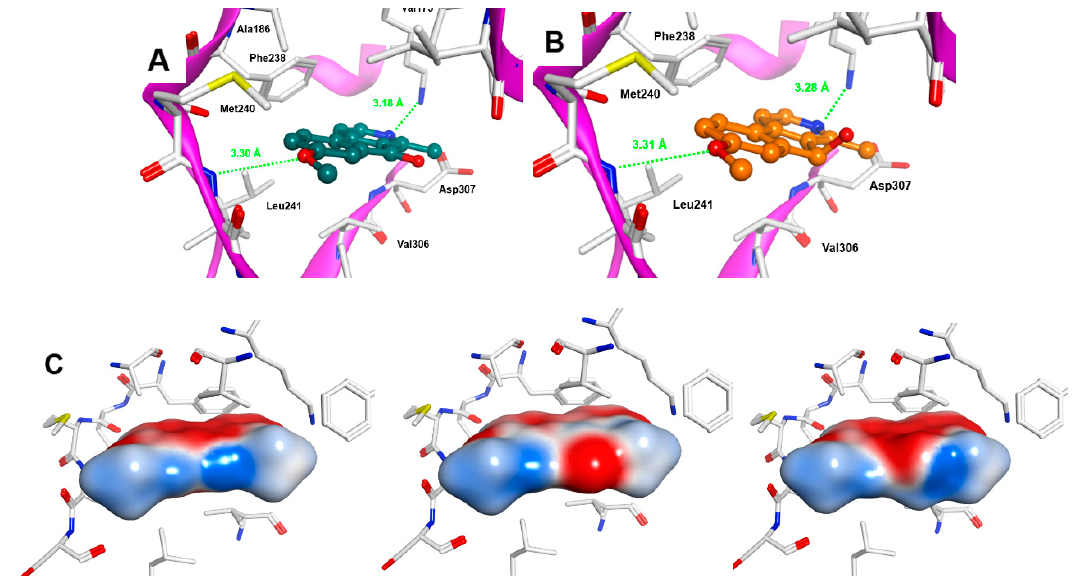
Figure 7. 9-Desazaharmine analogues ( A ) AnnHT2 and ( B ) AnnHT3 ( S enantiomer shown) docked into DYRK1A (PDB 4YU2; oxygen atoms in red, nitrogen atoms in blue). ( C ) Molecular electrostatic potentials of harmine (left), AnnHT2 (center) and AnnHT3 (right) (blue = electropositive, red = electronegative).